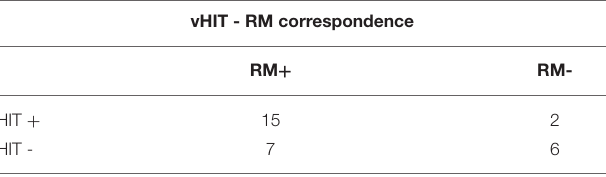
TABLE 5 | Ratio between positive and negative patients on MRI and patients with corrective saccades after the head movement and decreased gain for the horizontal canal ( p = 0.003).